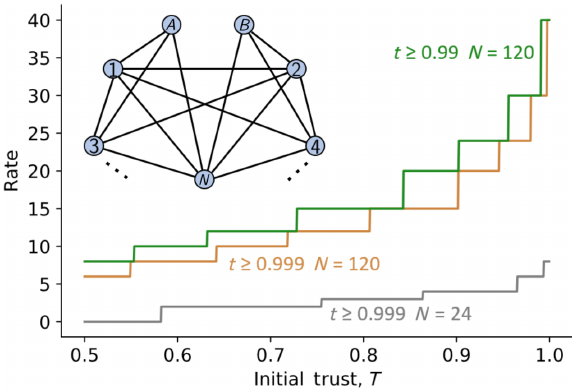
FIG. 9. The trade-off between trust and the rate. The figure cor- responds to the hypothetical scenario in which all of the shared keys have the same length (normalized to 1) and all N interme- diary nodes have the same trust T . The lines show the maximum rate achievable such that the total trust t is greater than or equal to a given value. The inset shows the N + 2 user network, which is fully connected except that there is no connection between A and B